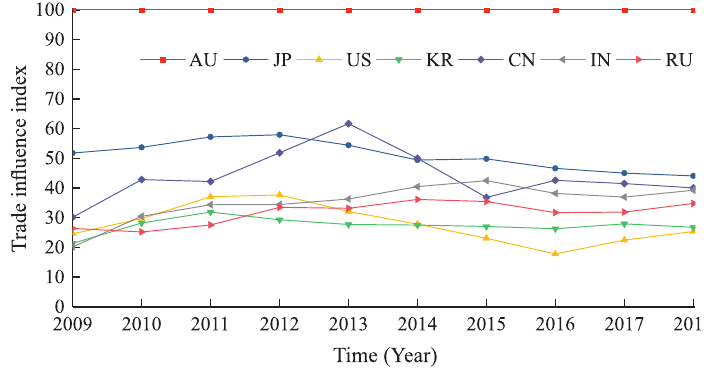
Figure 9. Evolution of dominant trade leading countries’ trade influence index